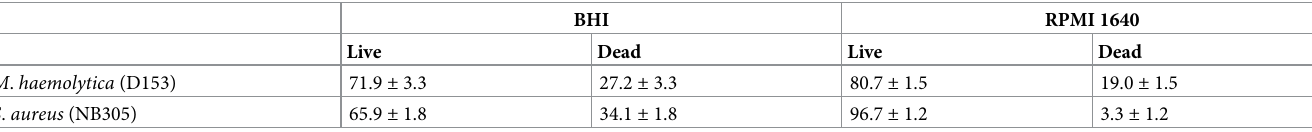
Table 1. Flow cytometry results of live and dead bacteria in the